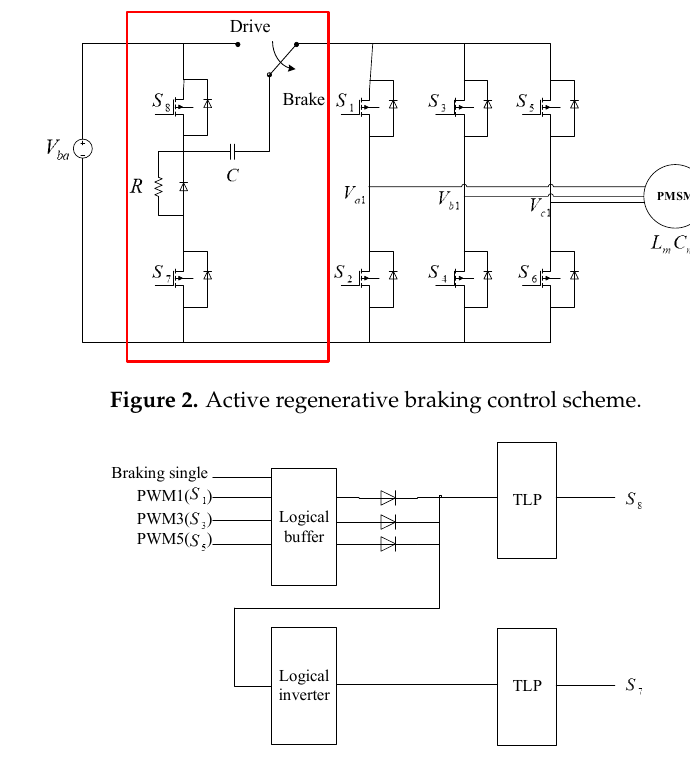
Figure 3. Control of MOSFET switches S 7 and S 8